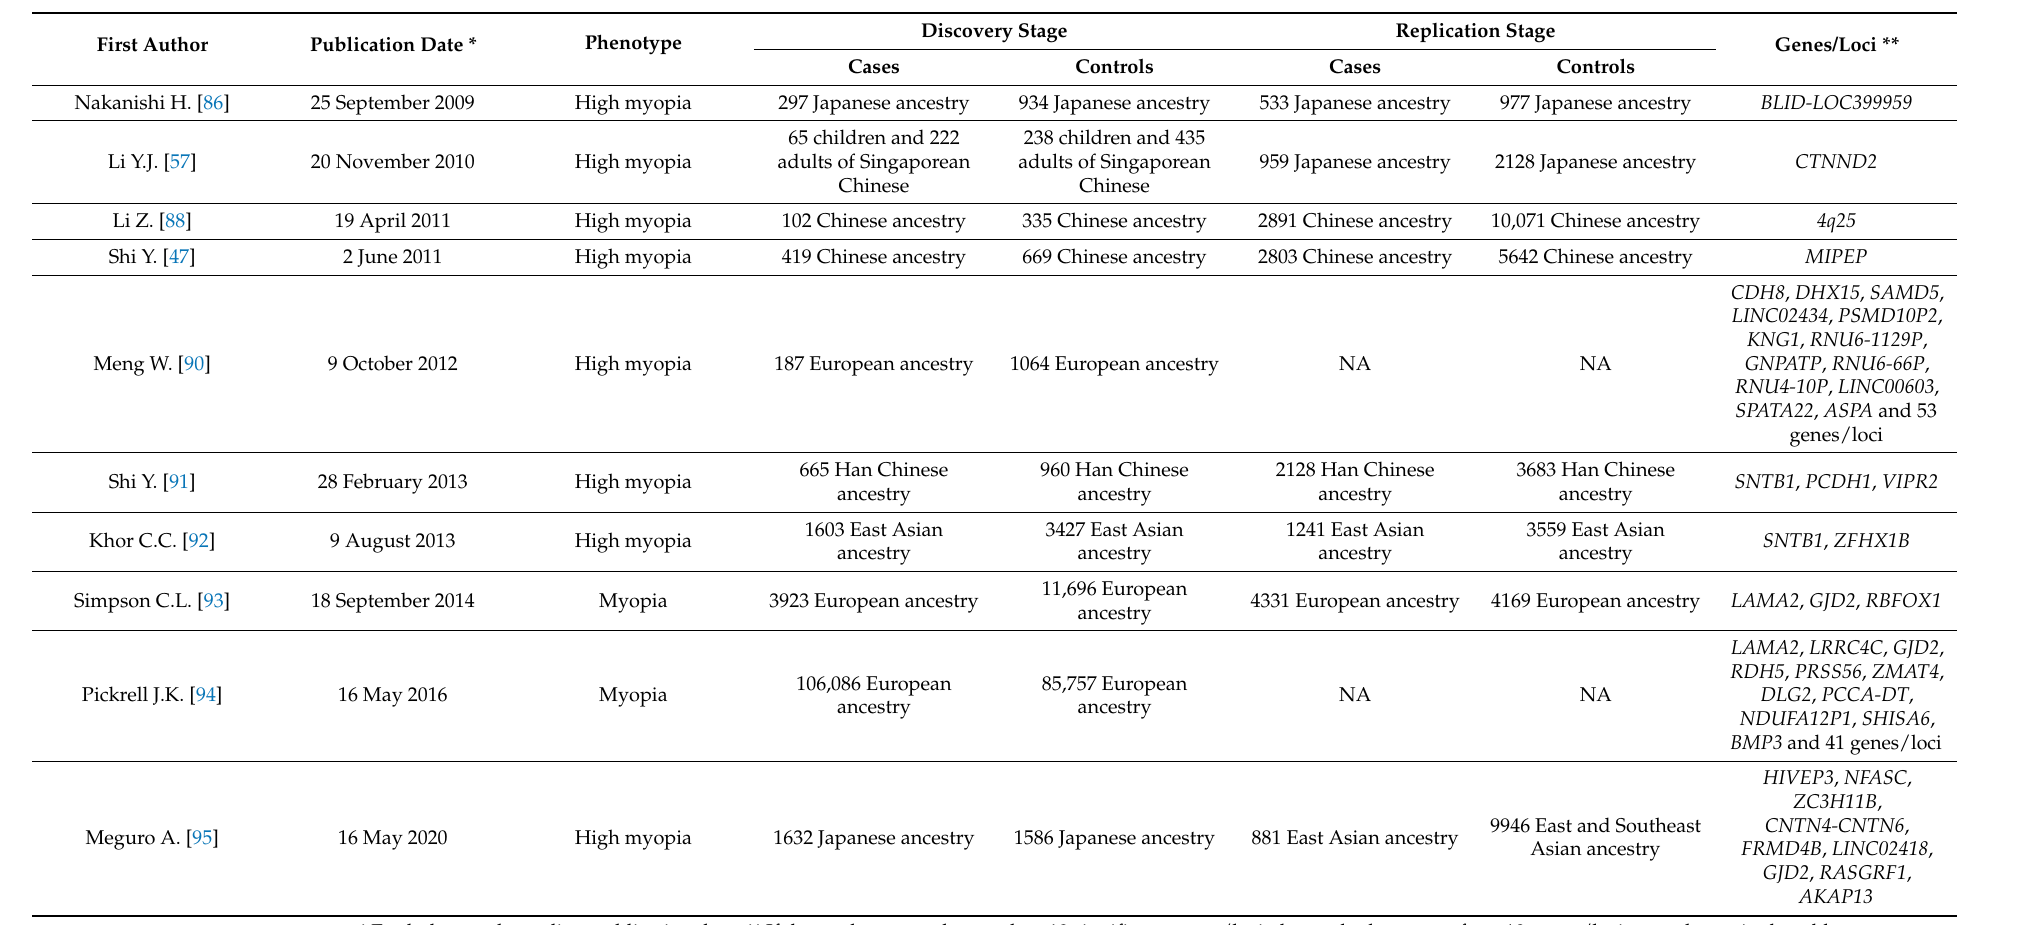
Table 2. Genome-wide association studies in myopia and top